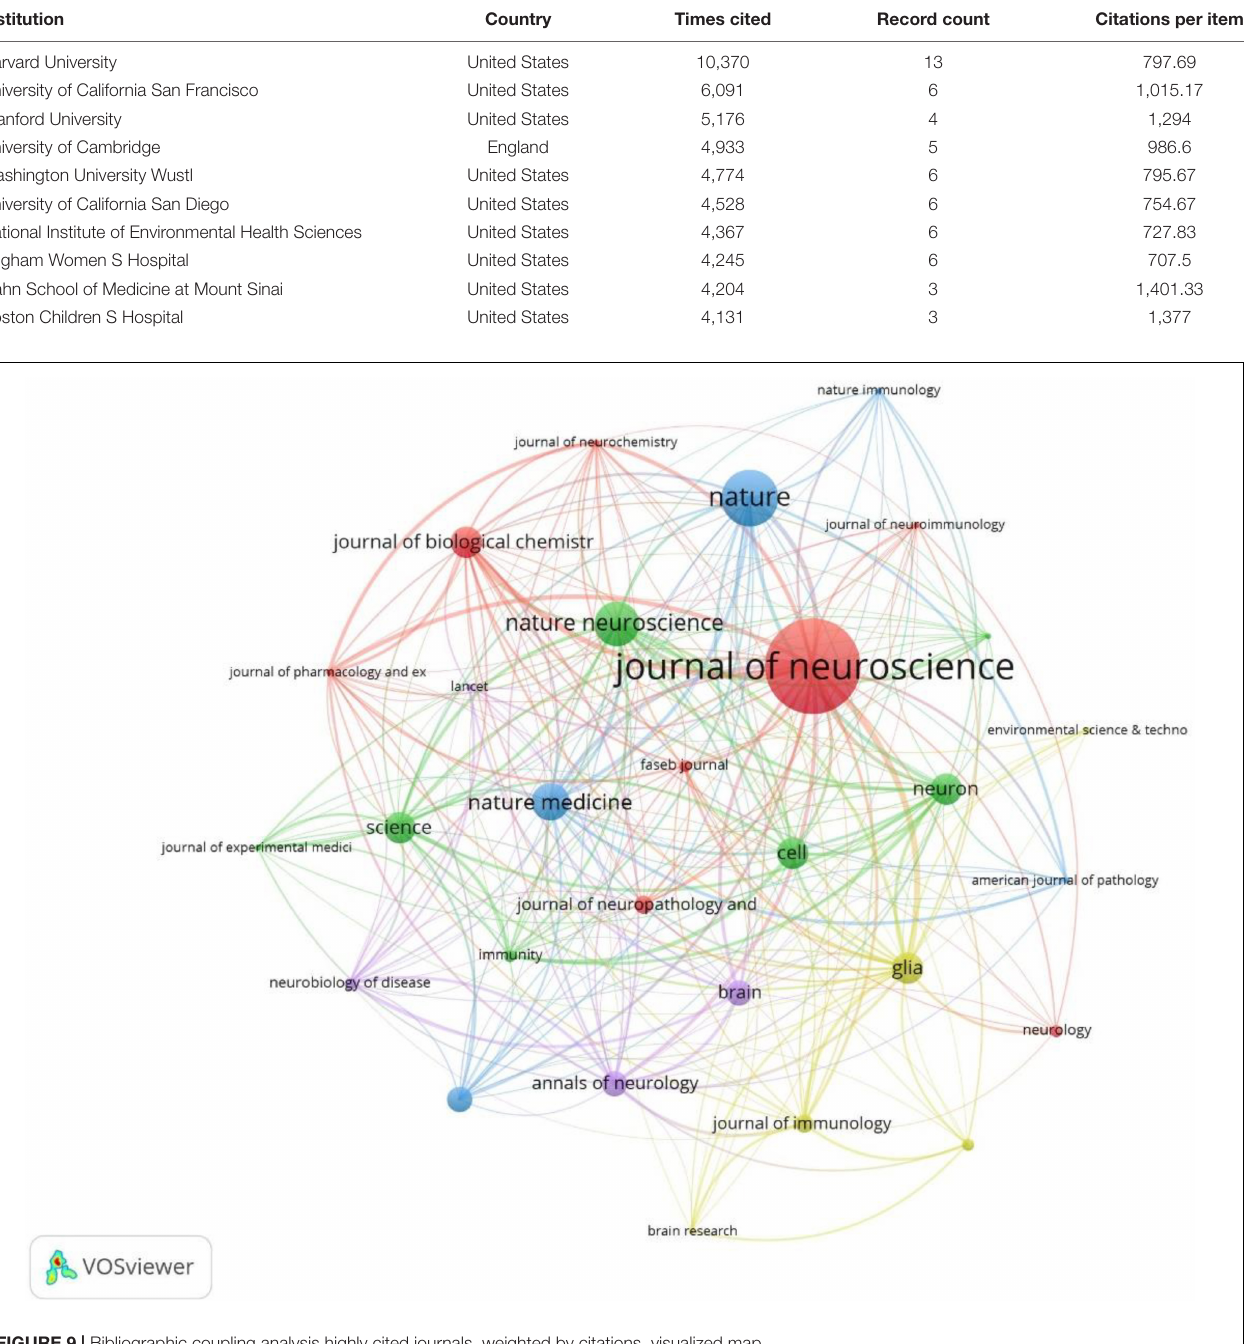
FIGURE 9 | Bibliographic coupling analysis highly cited journals, weighted by citations, visualized